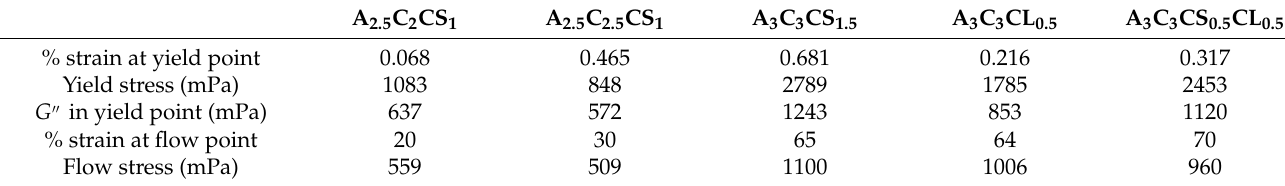
Figure 5. ( a ) Velocity and ( b ) shear stress distribution of various compositions. Velocity and shear rate distribution were calculated based on the shear-thinning factors n , K, and filament diameters changed due to the applied pressure. ( a ) represents the width of velocity distribution is viscosity dependent, and ( b ) represents high viscous composition will have more shear stress near the nozzle wall. Table 5. Yield and flow point and corresponding yield and flow